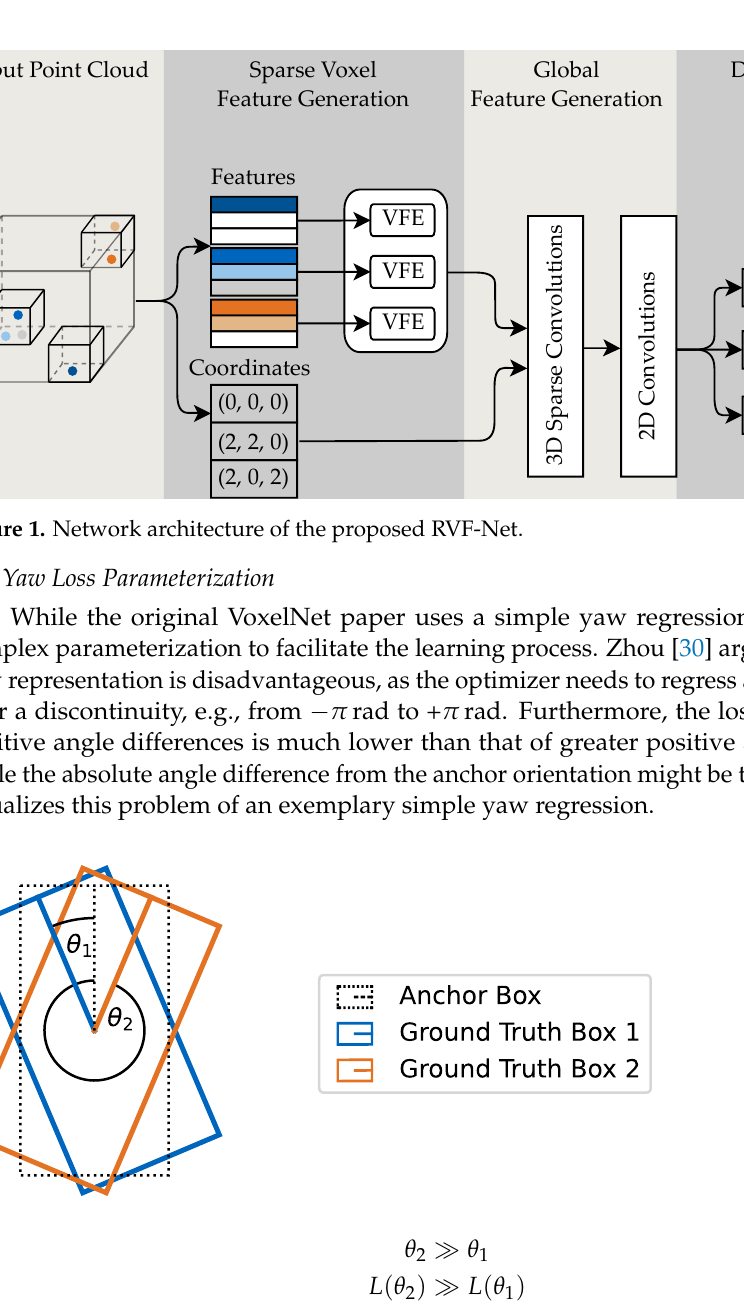
Figure 2. Vehicle bounding boxes are visualized in a BEV. The heading of the vehicles is visualized with a line from the middle of the bounding box to the front. The relative angular deviations from the orange and blue ground truth boxes to the anchor box are equal. However, the resulting loss value of the orange bounding box is significantly higher than that of the blue